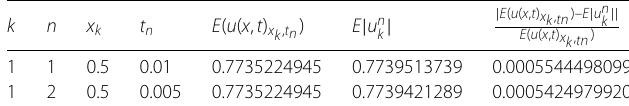
Table 2 β ∼ Beta distribution(1.0,2.0), α = 1